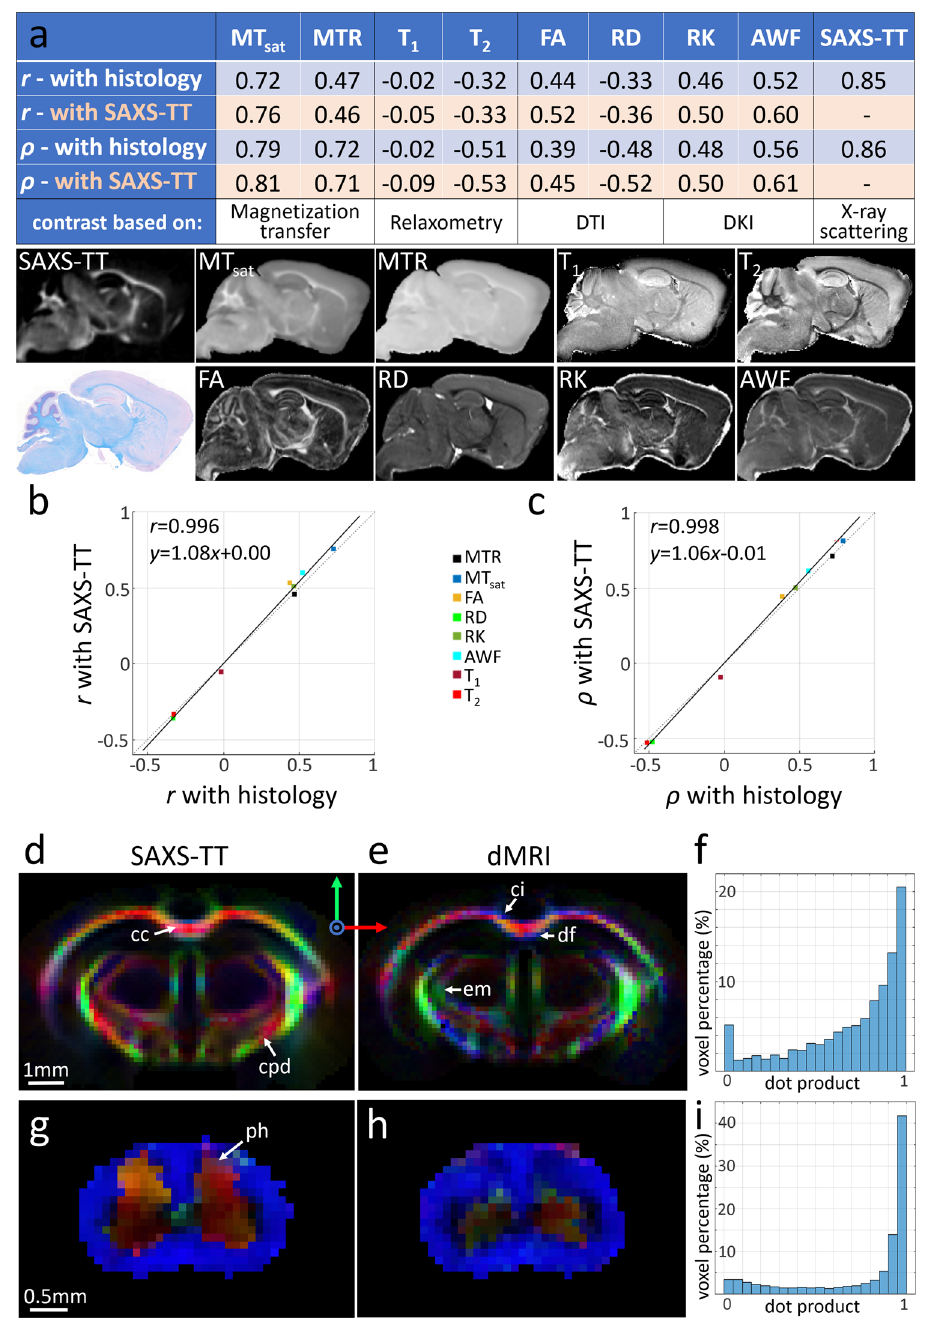
Fig. 5 Comparing SAXS-TT outcomes to histology and MRI. a Voxel-wise Pearson ( r ) and Spearman ( ρ ) correlations against histology- and SAXS-TT- derived myelin levels. All p values are 0, correlations over n = 361,042 voxels . Figures below table depict the same sagittal slice of the compared parameter maps. MT sat magnetization transfer saturation, MTR magnetization transfer ratio, FA fractional anisotropy, RD radial diffusivity, RK radial kurtosis, AWF axonal water fraction, DTI diffusion tensor imaging, DKI diffusion kurtosis imaging. b First against second row of table in a , identity line (dotted), linear fi t (black line) with indicated equation, and a Pearson correlation of r = 0.996 ( p = 1.1 × 10 − 7 ). c Third against fourth row of table in a , identity line (dotted), linear fi t (black line) with indicated equation, and a Pearson correlation of r = 0.998 ( p = 2.5 × 10 − 8 ). d , e , g , h Coronal mouse brain ( d , e ) and horizontal mouse spinal cord ( g , h ) sections depicting SAXS-TT- and dMRI-derived fi ber orientations, intensity weighted by SAXS-TT myelin levels, orientations interpreted by red-green-blue arrows. cc corpus callosum, cpd cerebral peduncle, ci cingulum, df dorsal fornix, em external medullary lamina of thalamus, ph posterior horn. f , i Dot product between SAXS-TT- and dMRI-derived fi ber orientations for brain ( f ) and spinal cord ( i ), where dot-product value of 1 denotes perfect collinearity, and 0 a 90° discrepancy. Source data are provided as a Source Data fi